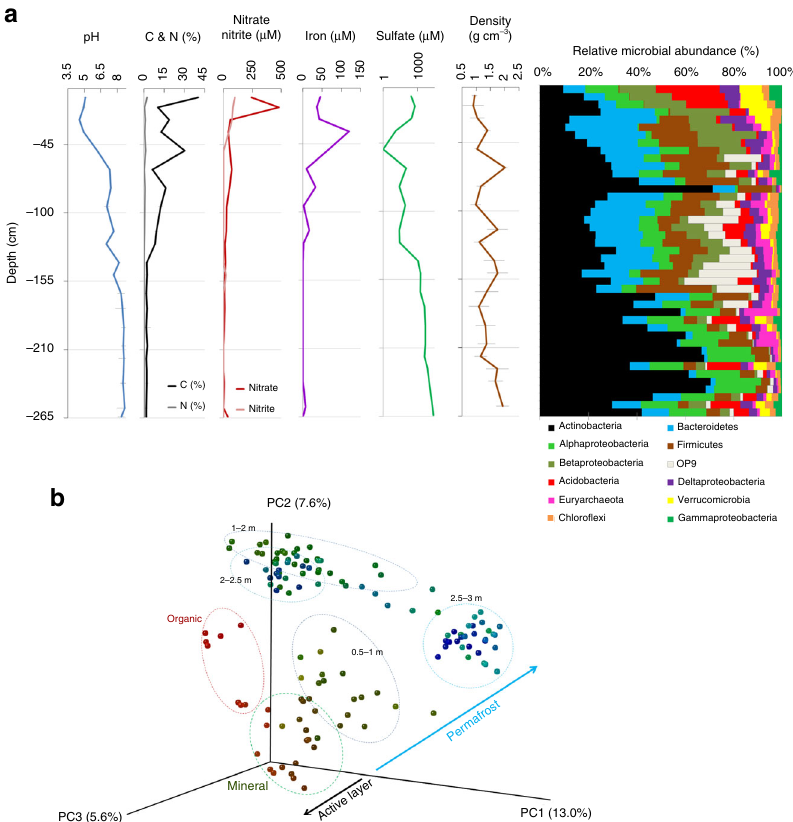
Fig. 2 Active layer and permafrost have contrasting microbiomes. Duplicate deep cores from a FC polygon were dissected in 5 cm intervals and analyzed to determine chemical and microbial composition. a Changes in soil and permafrost chemistry and microbial community composition with depth are reported as averages ( n = 8 between 0 to 1 m, n = 4 between 1 to 2.64 m). Standard deviations of chemical measurements are represented by gray bars. Standard deviations among technical and biological replicates of microbial community relative abundances are provided in Supplementary Table 5. b Unifrac analysis of 16S rRNA sequence variation along the depth gradient from duplicate cores of a FC polygon. Samples were grouped according to organic (red) and mineral (brown-green) in active layer and permafrost (green-blue) horizons. The variance explained by each principal component (PC) axis is given